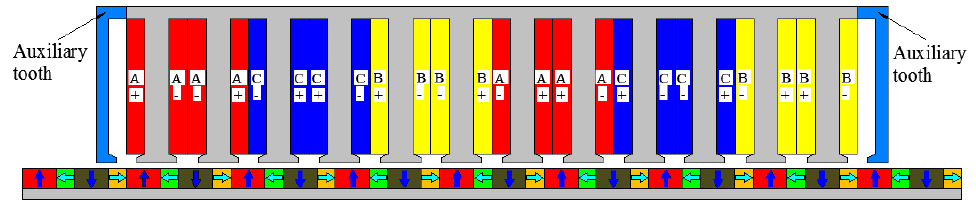
Figure 1. Schematic illustration of a permanent magnet linear motor (PMLM) with double-layer concentrated windings.